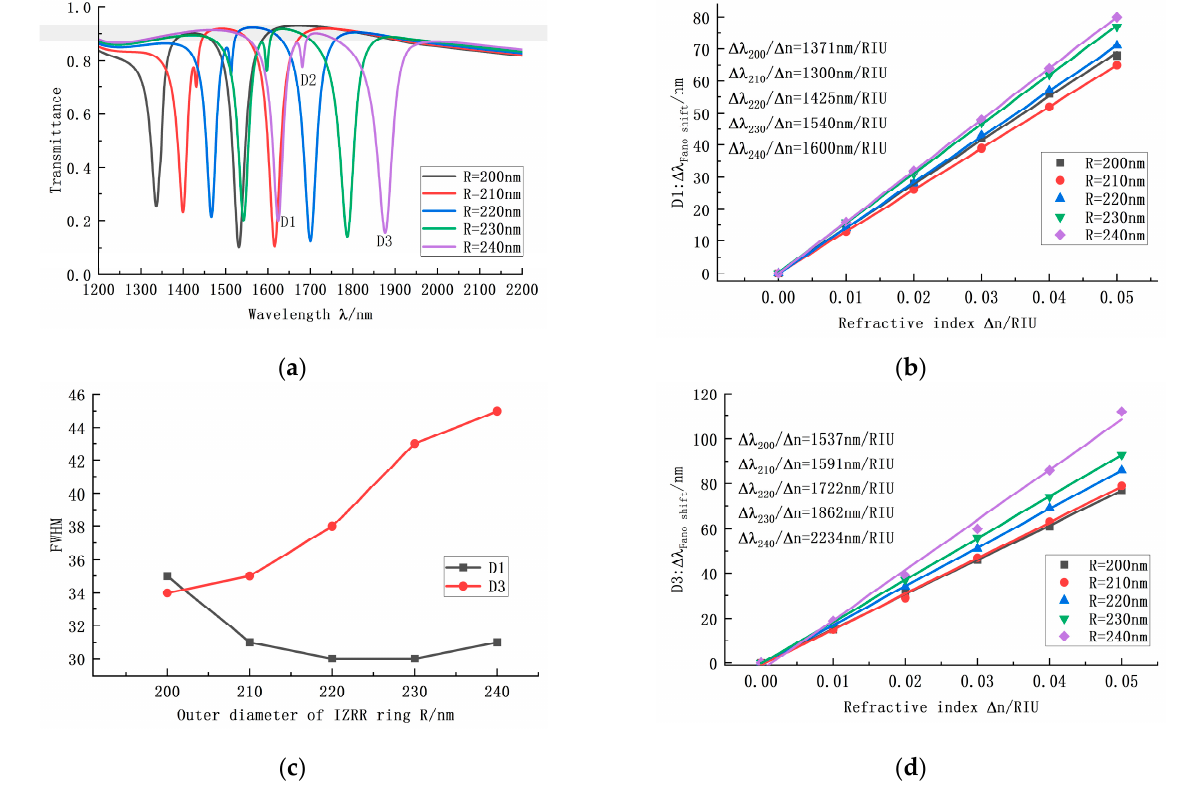
Figure 5. ( a ) Transmission curves of the IZRR structure under different ring radii. ( b ) Sensitivity curve fitting at D1 under different ring radii. ( c ) Bandwidth variation at D1 and D3 under different ring radii. ( d ) Sensitivity curve fitting at D3 under different ring radii.